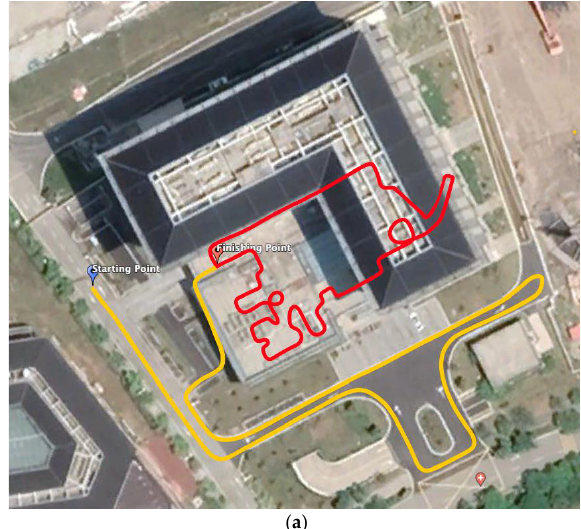
Table 2. SLAMTEC Mapper technical